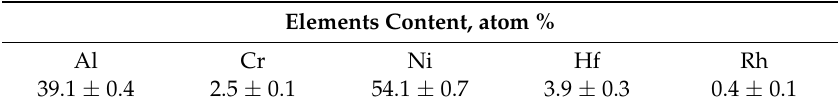
Figure 9. Elements’ distribution on the cross-section of the rhodium- and hafnium-modified aluminide coating.